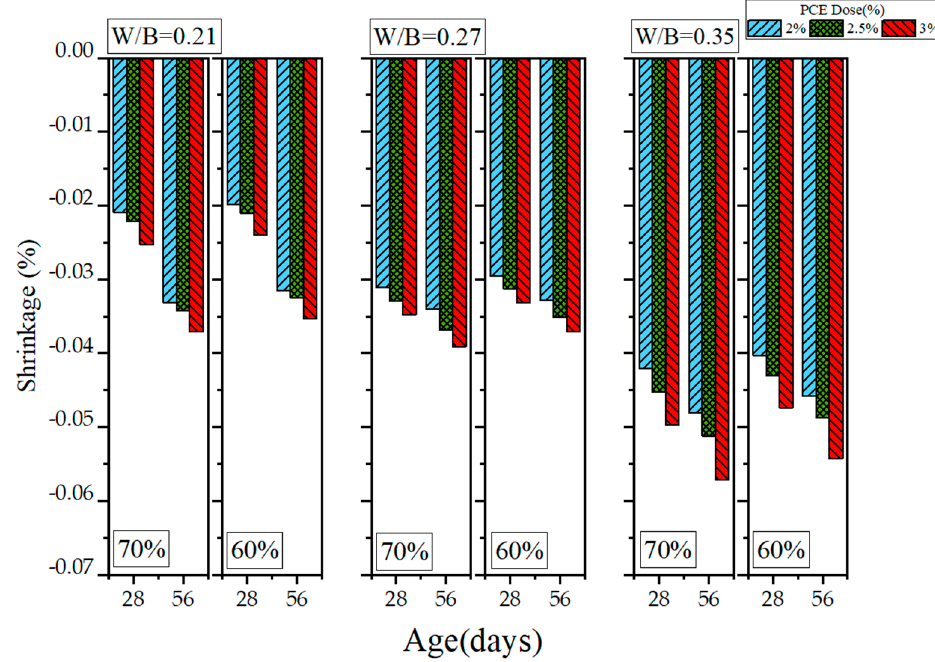
Figure 19. Length changes of green and ecofriendly grouting material with PCE.